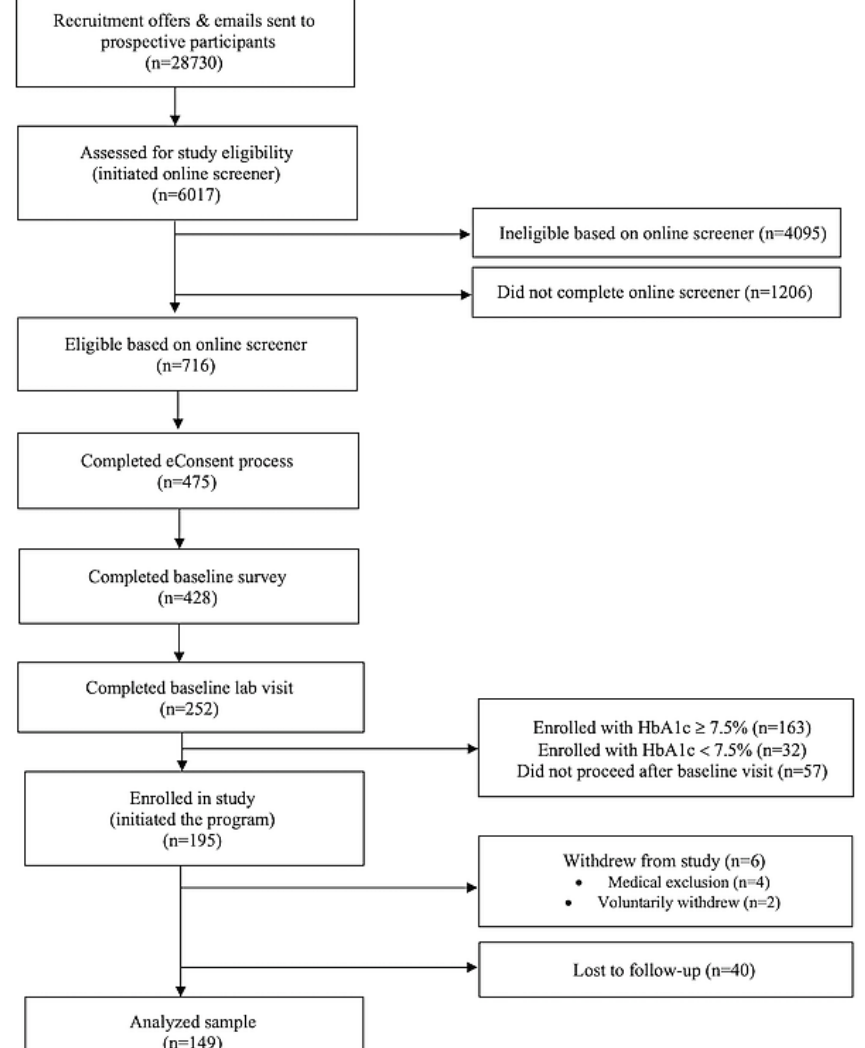
Figure 1. Study participant flowchart. HbA 1c : hemoglobin A 1c